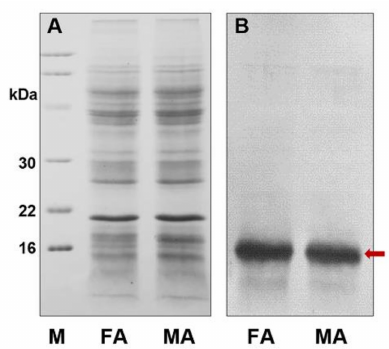
Figure 5. SDS-PAGE and Western blot of extracts from male and female antennae of Peridroma saucia adults. ( A ) SDS-PAGE; ( B ) Western blot. FA: female antennae; MA: male antennae. Expression of PsauGOBP1 does not significantly differ in male antennae vs. female antennae. Target proteins are indicated by a red arrow. Molecular weight markers (M) are, from the top, 94, 66, 45, 30, 22, and 16 kDa.